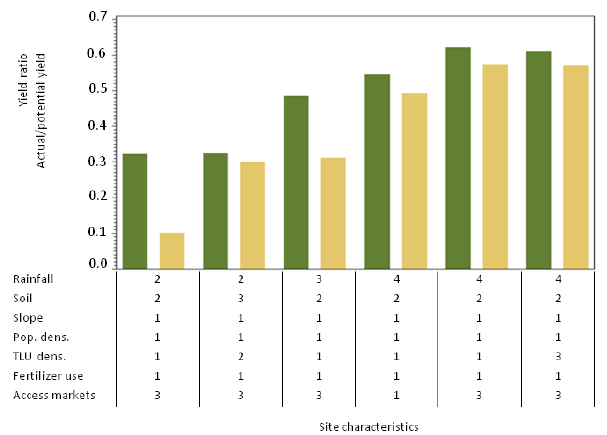
Figure 8. Comparing yields under “low” (green) and “severe” (sandy brown) degradation for uniform sites defined by six variables (rainfall, soil, slope, population, TLU, markets) for “moderate” fertilizer applications. Codes on x axis for rainfall are 1 = <200; 2 = 200–400; 3 = 400–700; 4 = >700mm; for soils 1 = unsuitable; 2 = not suitable; 3 = moderately suitable; 4 = suitable; for slope 1 = no slope; 2 = undulating; for population density 1 = <600; 2 = 600–9000; 3 = >9000pkm − 2 ; for TLU density 1 = <21; 2 = 21–32; 3 = >32TLUkm − 2 ; fertilizer use 1 = <50; 2 = 50– 150; 3 = >150kgha − 1 ; and for access to markets 1 = 1. cat. road<10km; 2 = 2. cat. road<10km; 3 = 3. cat. road<10km; 4 =